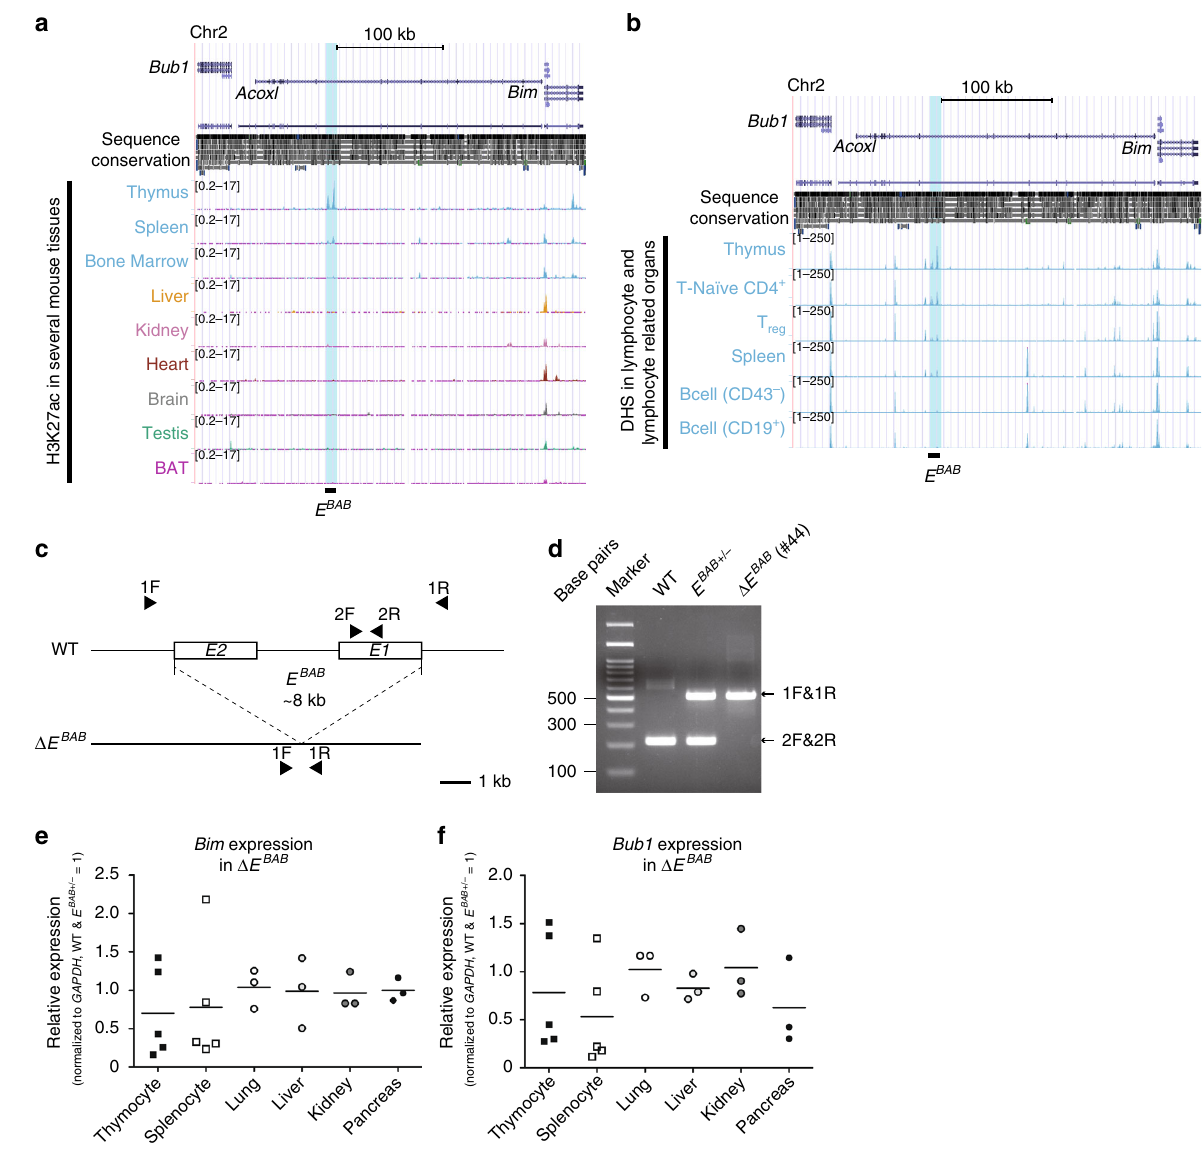
Fig. 1 Identi fi cation of a T cell-speci fi c cis -regulatory element E BAB . a ChIP-seq visualization of H3K27ac in several mouse tissues. H3K27ac pro fi les from the thymus, spleen, bone marrow, liver, kidney, heart, brain, testis, and brown adipose tissues (BAT) are visualized using the UCSC genome browser (mm9). The E BAB region is highlighted. b DNase hypersensitivity sites (DHS) in the same locus shown in ( a ). DHS pro fi les from the thymus, T-Naïve CD4 + , regulatory T (T reg ) cells, spleen, and B cells (CD43 − or CD19 + ) are visualized using the UCSC genome browser (mm9). The E BAB region is highlighted. c Schematic representation of Δ E BAB . Arrowheads indicate the primers listed in Supplementary Data 1. d Genomic PCR against the E BAB locus of WT, heterozygotes ( E BAB + / − ), and Δ E BAB mice. A representative gel-image of founder #44-derived DNAs is shown. See also Supplementary Fig. 2 for the results from #47- and #50-derived DNAs. e , f qPCR analysis for Bim ( e ) and Bub1 ( f ) on thymocytes, splenocytes, lung, liver, kidney, and pancreas. Data are pooled from fi ve independent experiments (thymocyte, splenocyte; n = 5 WT and E BAB + / − – Δ E BAB littermate pairs, 7 – 17 weeks old, mean ± s.d.) or three independent experiments (lung, liver, kidney, pancreas; n = 3 WT & E BAB + / − – Δ E BAB littermate pairs, 10 – 17 weeks old). Each symbol represents an individual mouse; small horizontal lines indicate the mean. No statistically signi fi cant differences between WT and E BAB + / − and Δ E BAB were detected ( P ≥ 0.05; unpaired two-tailed Student ’ s t test)